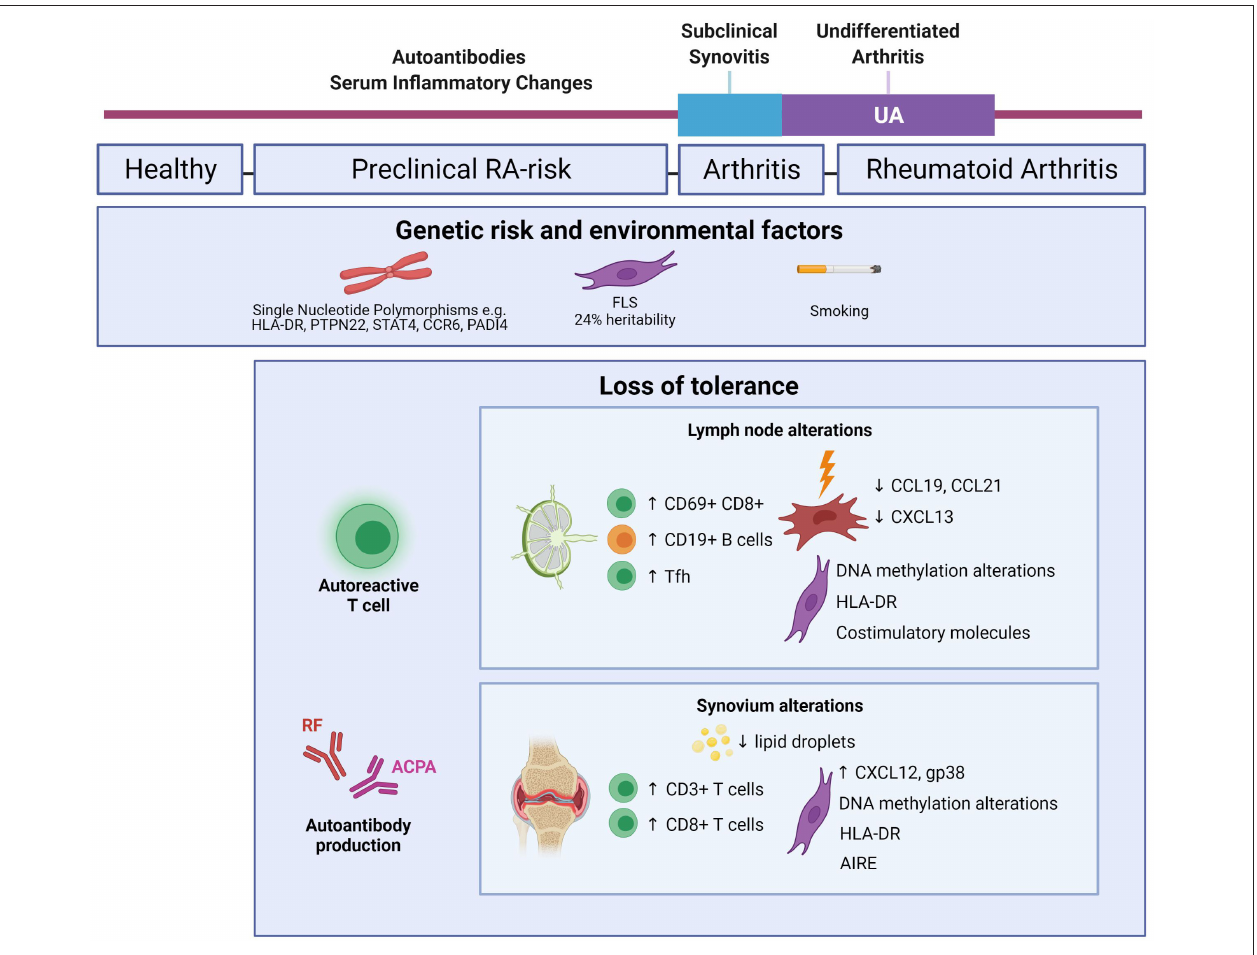
FIGURE 1 | Mapping immune alterations during RA development. Schematic figure highlighting known changes within the immune system of RA-risk individuals and early RA. Genetic and environmental factors increase the likelihood of RA development in the healthy human population (5, 8). Depending on the risk profile, about 30% of RA-risk individuals go on to clinically develop RA ( 6). LN alterations are based on inguinal LN needle biopsy research comparing RA-risk individuals with healthy volunteers and early RA patients ( 9–13). Synovium alterations are based on synovial tissue biopsy research in RA-risk individuals and early RA